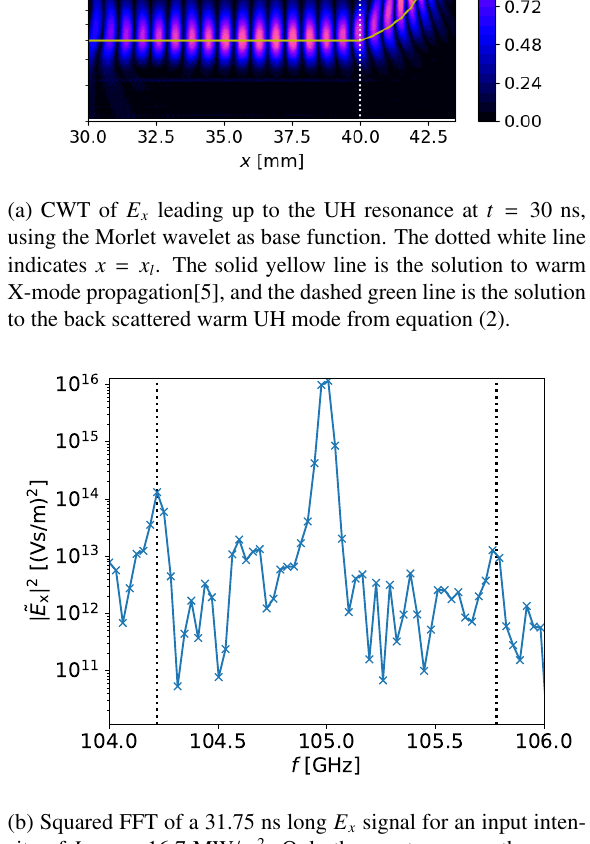
(b) Squared FFT of a 31 . 75 ns long E x signal for an input inten- sity of I pump = 16 . 7 MW / m 2 . Only the spectrum near the pump wave frequency and the expected UH daughter wave is shown. The plot is centered around the pump at f 0 = 105 . 00 GHz and the two vertical dotted lines placed symmetrically around the pump wave mark the two PDI products f 2 and f 3 . Figure 1: Plots showing transforms of the longitudinal electric field component, E x , into k -space (a) and f -space (b).